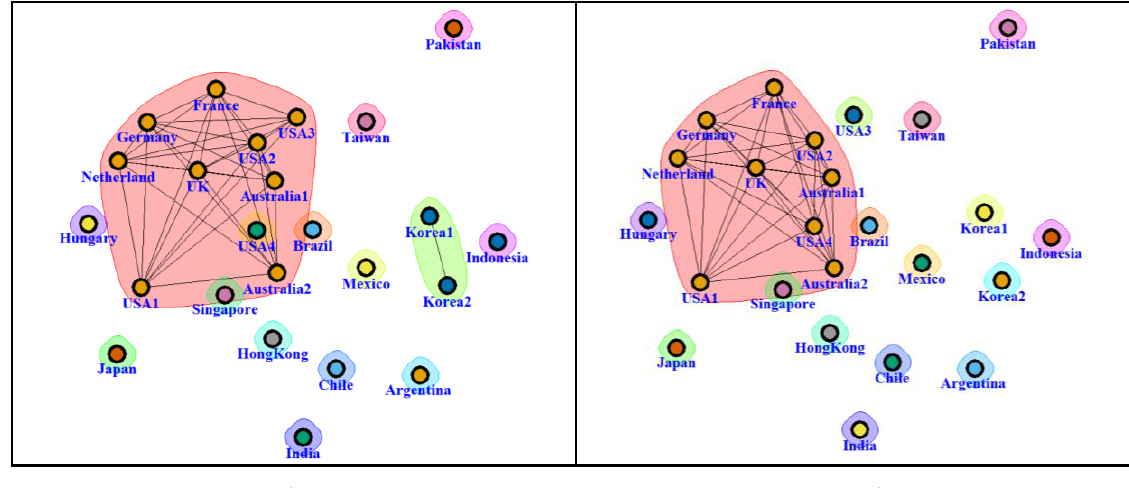
Figure 7. Community structures of return and volatility for global 24 stock markets of 20-year length time series. The structures of return and volatility are almost identical. The western developed countries such that European, North American and Oceanian countries mainly form a community.